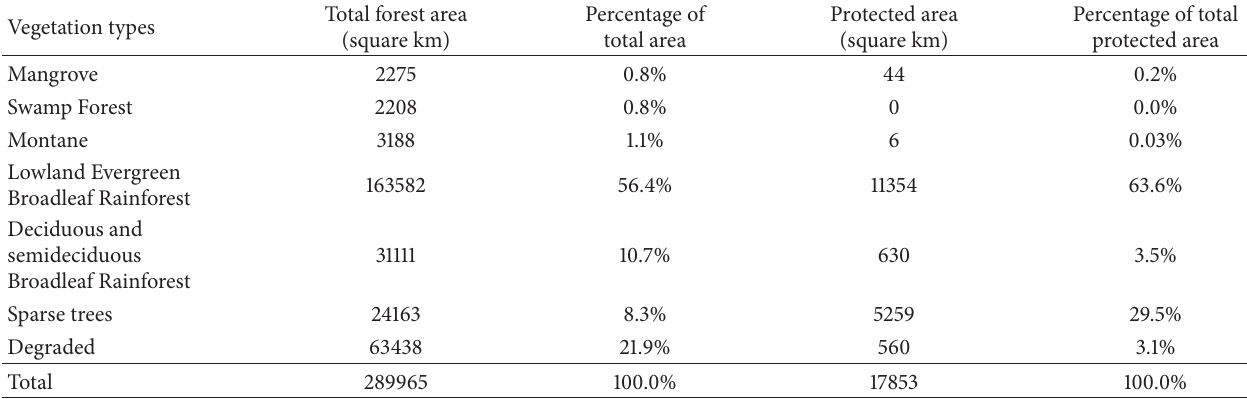
Table 1: Major vegetation types within the current range of the Grey Parrot in relation to total forest zone and protected areas [3]. Total forest area Percentage of Protected area Percentage of total Vegetation types (square km) total area (square km) protected area Mangrove 2275 0.8% 44 0.2% Swamp Forest 2208 0.8% 0 0.0% Montane 3188 1.1% 6 0.03% Lowland Evergreen 163582 Broadleaf Rainforest Deciduous and semideciduous 31111 Broadleaf Rainforest Sparse trees 24163 Degraded 63438 Total 289965 100.0% 17853